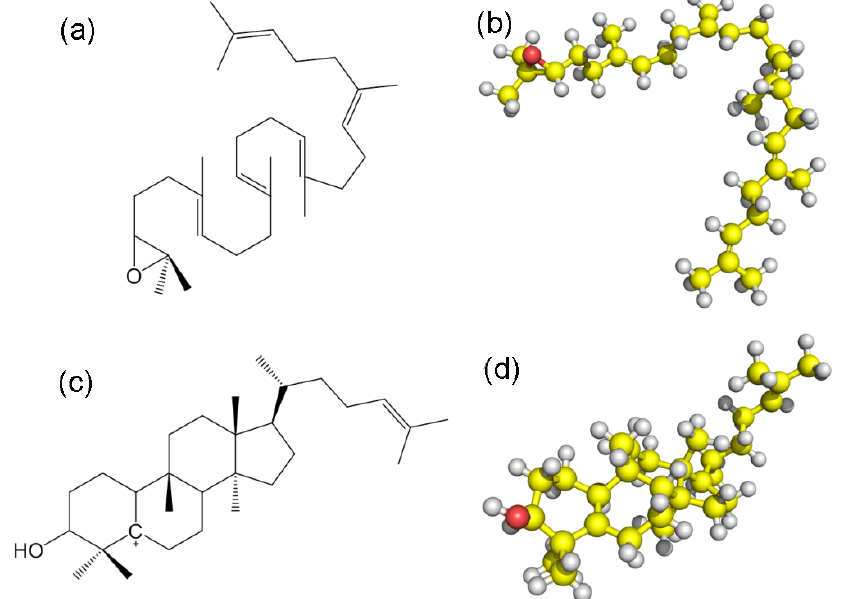
Figure A3. Conformations of 2,3-oxidosqualene and C-4 cation after geometry optimization. ( a , b ) 2,3-oxidosqualene ( c , d ) C-4 cation. Yellow: carbon atom; Red: oxygen atom.